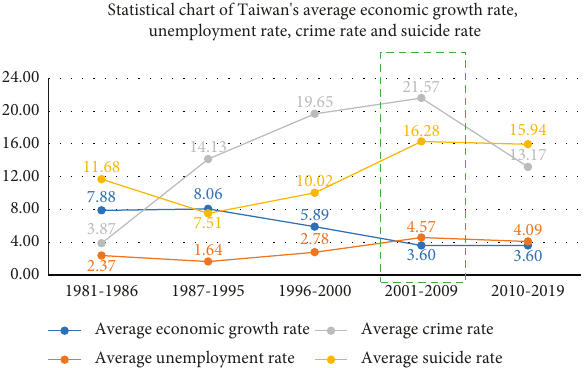
Figure 1: Statistical chart between Taiwan’s average economic growth rate, unemployment rate, crime rate, and suicide rate from 1981 to 2019. Data source: National Statistics, R.O.C. (Taiwan), National Police Agency, Ministry of Interior, R.O.C.